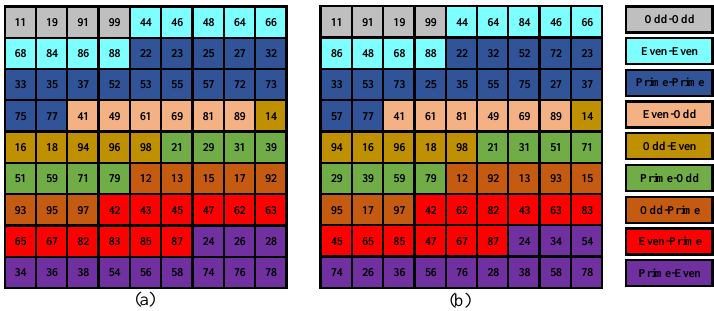
Figure 1. ( a ) OEP and ( b ) IOEP arrangement for 9 × 9 PV